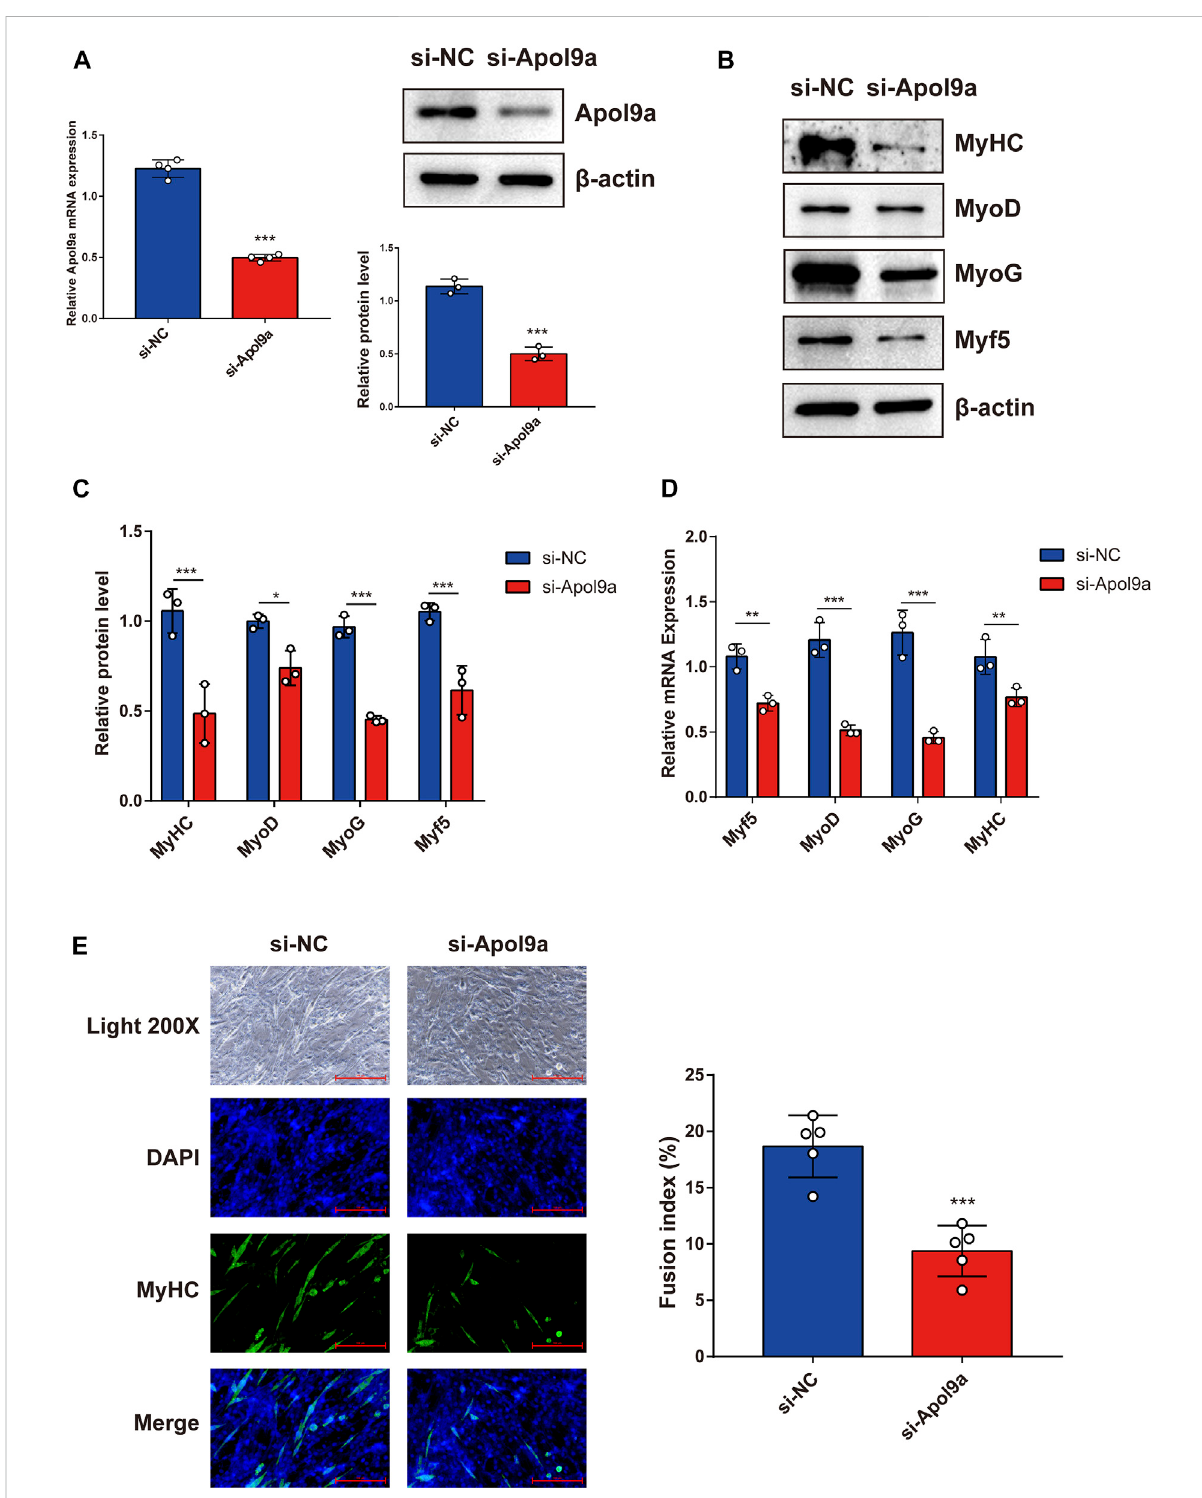
FIGURE 3 Apol9a knockdown inhibits C2C12 myogenesis. C2C12 cells were induced to differentiate after si-NC or si- Apol9a transfection for 4 days. (A) qPCR and western blot validation of the ef fi ciency of Apol9a knockdown in C2C12 cells. (B) Protein expression levels of MyHC, MyoD, Myf5, and MyoG were estimated through western blot analysis after si-NC and si- Apol9a transfection. (C) Gray scale analysis of western blot results of (B) determined using ImageJ software. (D) qPCR was performed to assess the mRNA expression levels of several myogenic differentiation genes ( Myf5 , MyoD , MyoG , and MyHC ). (E) Myotube formation can be observed in fl uorescence images of DAPI (blue) and MyHC antibody-stained (green) myotubes of C2C12 cells transfected si-NC or si- Apol9a . Scale bar, 100 μ m. The fusion index (%) was quanti fi ed and is shown on the right. The data are expressed as mean ± SEM of at least three independent experiments. * p < 0.05, ** p < 0.01, *** p < 0.001 vs. si-NC